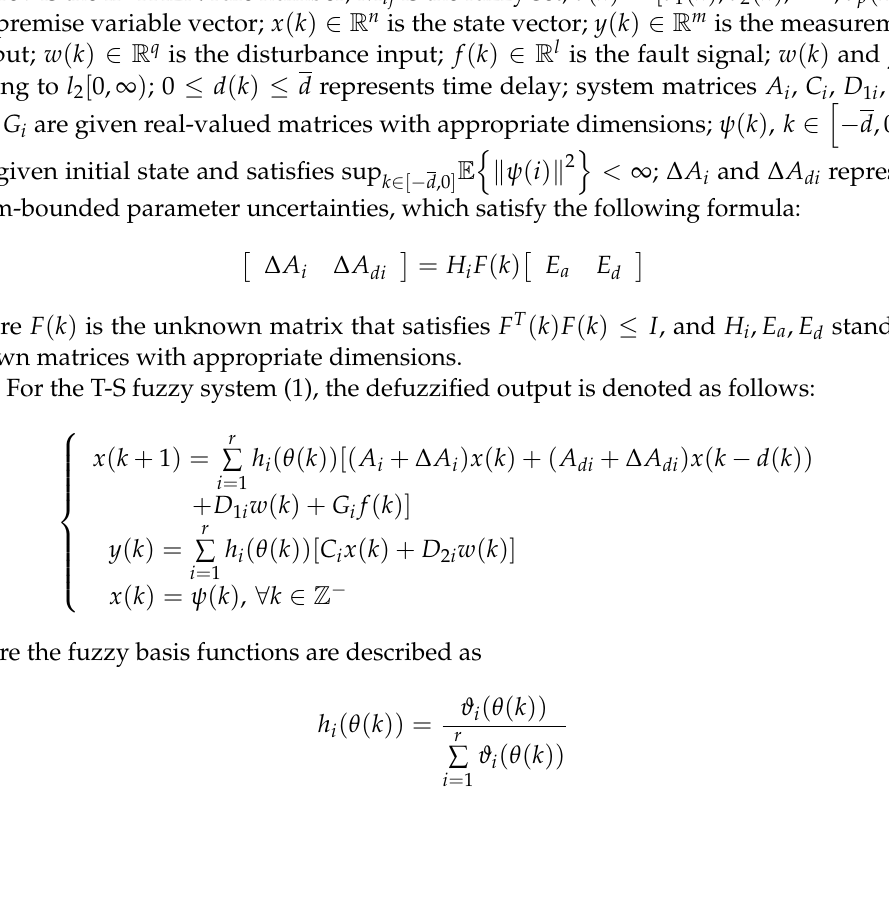
( ) d t is the term of variable time delay. In this paper, the T-S fuzzy model is